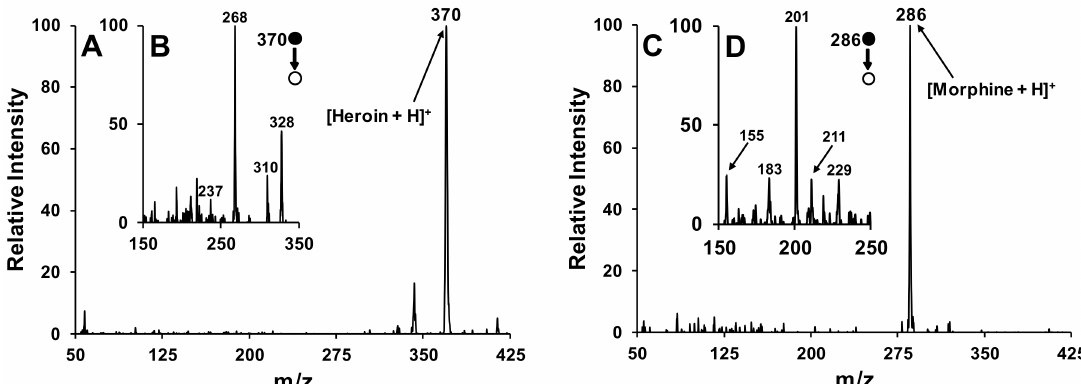
Figure 3. ( A ) PSI-MS spectrum from a swab used to probe heroin evidence, displaying the protonated molecule, [M + H] + , at m / z 370. ( B ) Corresponding PSI-MS/MS spectrum of the protonated precursor ion, yielding characteristic fragmentation used for chemical identification. ( C ) PSI-MS spectrum collected from an injectable solution of morphine sulfate, displaying the protonated molecule at m / z 286. ( D ) Corresponding PSI-MS/MS spectrum of protonated morphine, yielding characteristic